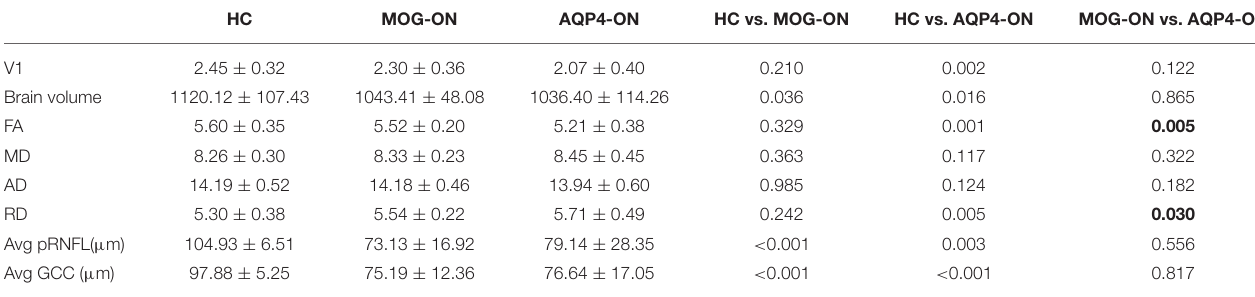
TABLE 2 | MRI and OCT results from HCs and optic neuritis subgroup. HC MOG-ON